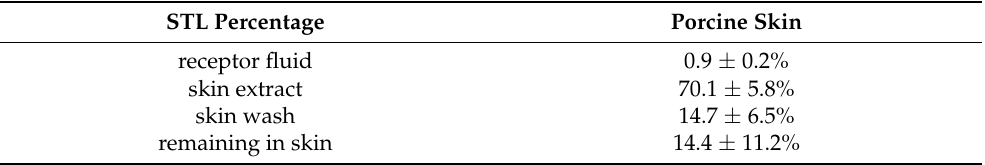
Table 4. Portions of H-DMCA in receptor fluids, skin extracts, skin washes and remaining portions in dermal absorption experiments with porcine skin ( n =